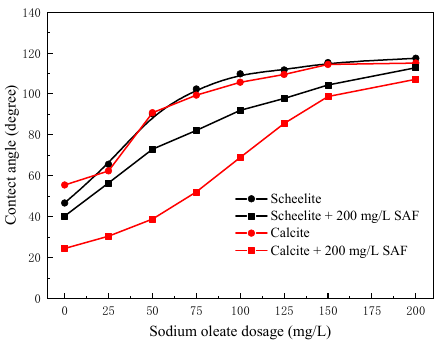
Figure 7. Contact angle of the mineral surfaces as functions of the sodium oleate dosage in